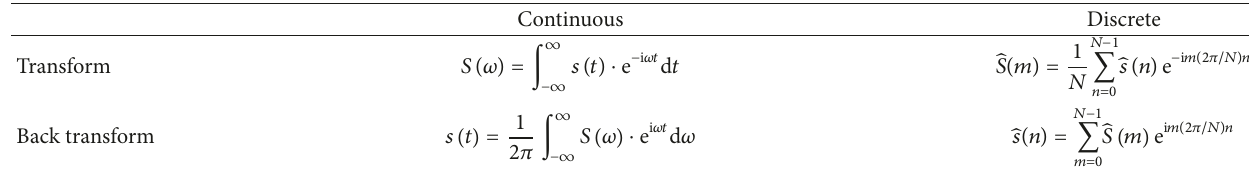
Table 1: Continuous and discrete Fourier